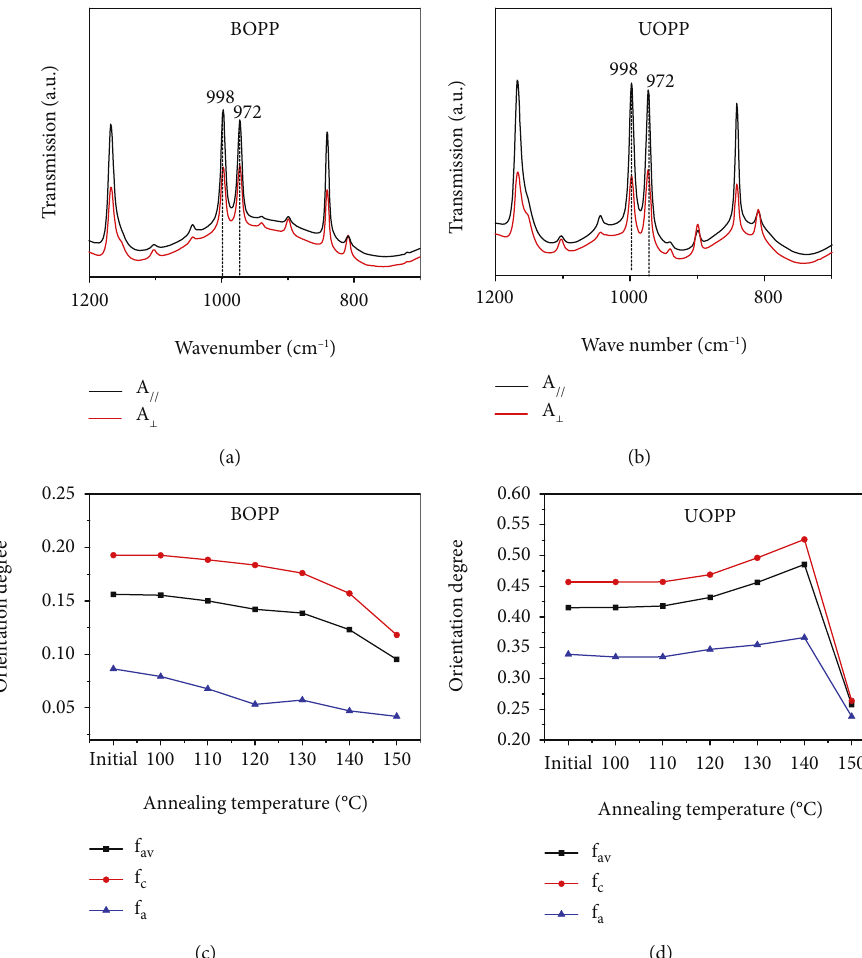
Figure 7: Polarized FTIR spectra of (a) BOPP and (b) UOPP fi lms. Changes in the orientation function with T fi